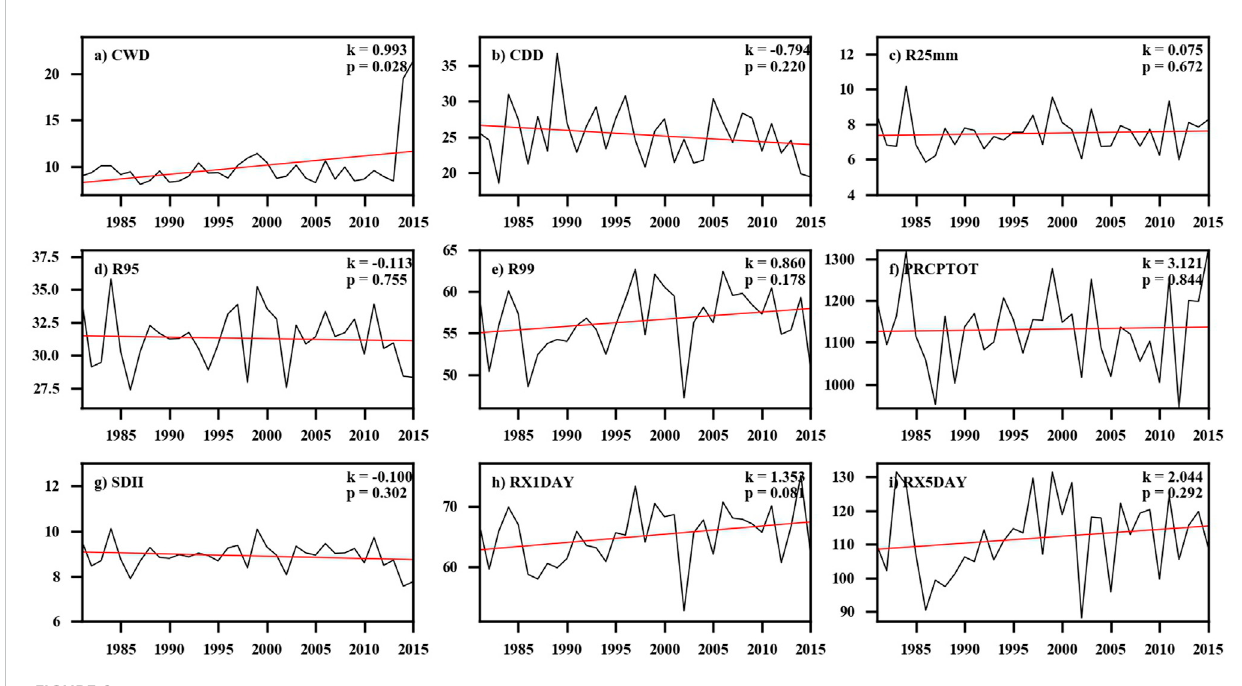
FIGURE 2 TimeseriesofprecipitationindicesovertheMLYRfrom1979to2015.Theredlineindicatesalineartrend. (A) CWD; (B) CDD; (C) R25mm; (D) R95; (E) R99; (F) PRCPTOT; (G) SDII; (H) RX1DAY; (I)